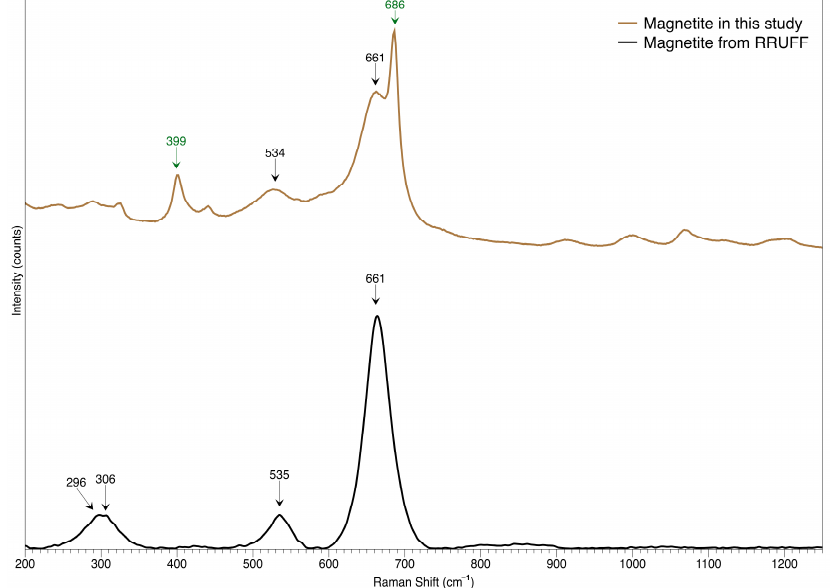
Figure 8. Raman spectrum analysis identifies these skeleton and grey platy inclusions as magnetite. Peaks at 661 and 535 cm − 1 agree with two prominent peaks of magnetite, according to RRUFF online database, while peaks at 686 and 399 cm − 1 may be assigned to the emerald host.